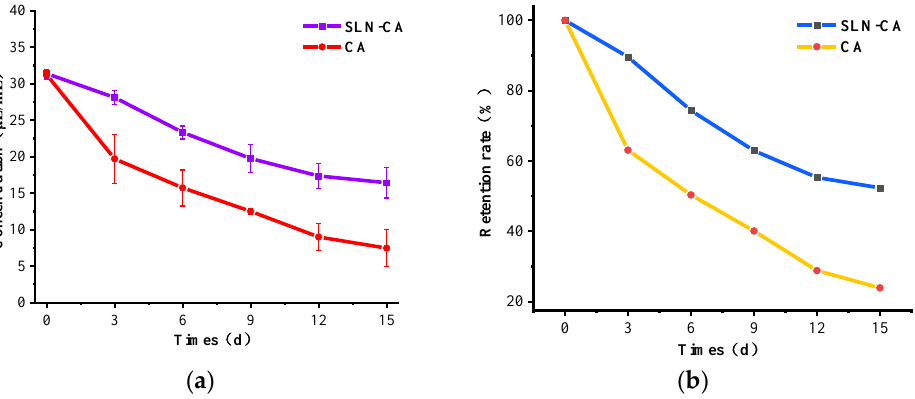
Figure 11. Results of concentration change ( a ) and retention ( b ) of SLN-CA with the same concentration of unencapsulated CA placed at 25 °C for 15 days. Error bars show the standard deviation of the means (three replications).